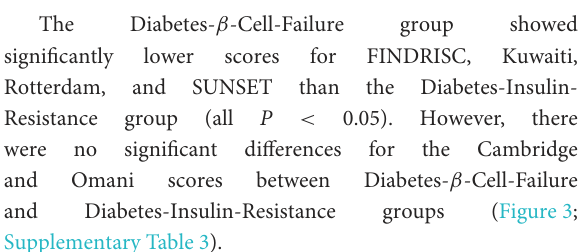
The Diabetes- β -Cell-Failure group had lower BMI, lower waist circumference and lower VAT compared to the Diabetes- Insulin-Resistance group (all P < 0.001) (Figure 2). Obesity prevalence was also lower in Diabetes- β -Cell-Failure vs. Diabetes-Insulin-Resistance (10% vs. 77%) ( P < 0.001). TG levels were lower in the Diabetes- β -Cell-Failure group ( P < 0.05), but no significant differences were noted for TC, LDL, and HDL levels between etiology